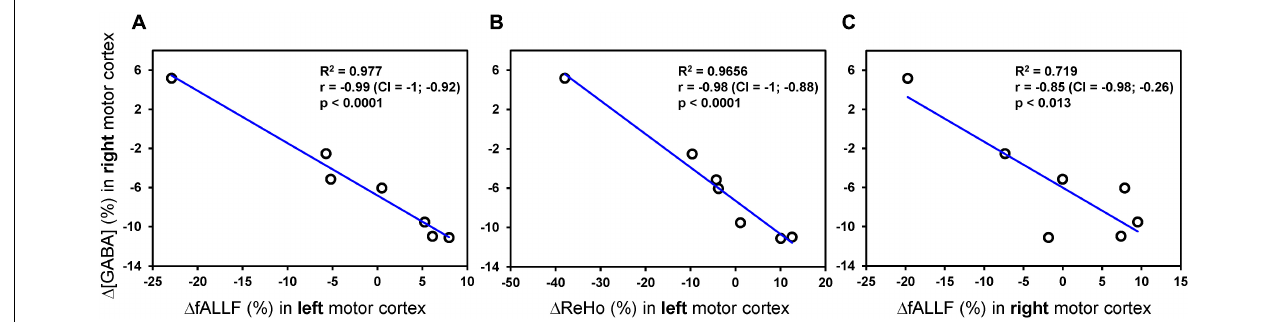
FIGURE 5 | Pearson correlations analyses between rTMS-induced percent changes of MRS and connectivity metrics. Only Pearson correlations with p < 0.05 (uncorrected) are displayed. The plots show a strong linear relationship between percent changes of GABA concentration [ (cid:49) (GABA)] in contralateral (right) motor cortex and both (cid:49) fALLF (A) and (cid:49) ReHo (B) in ipsilateral (left) motor cortex. A similar relationship, but with more variance, was seen with the (cid:49) fALLF in contralateral (right) motor cortex (C)